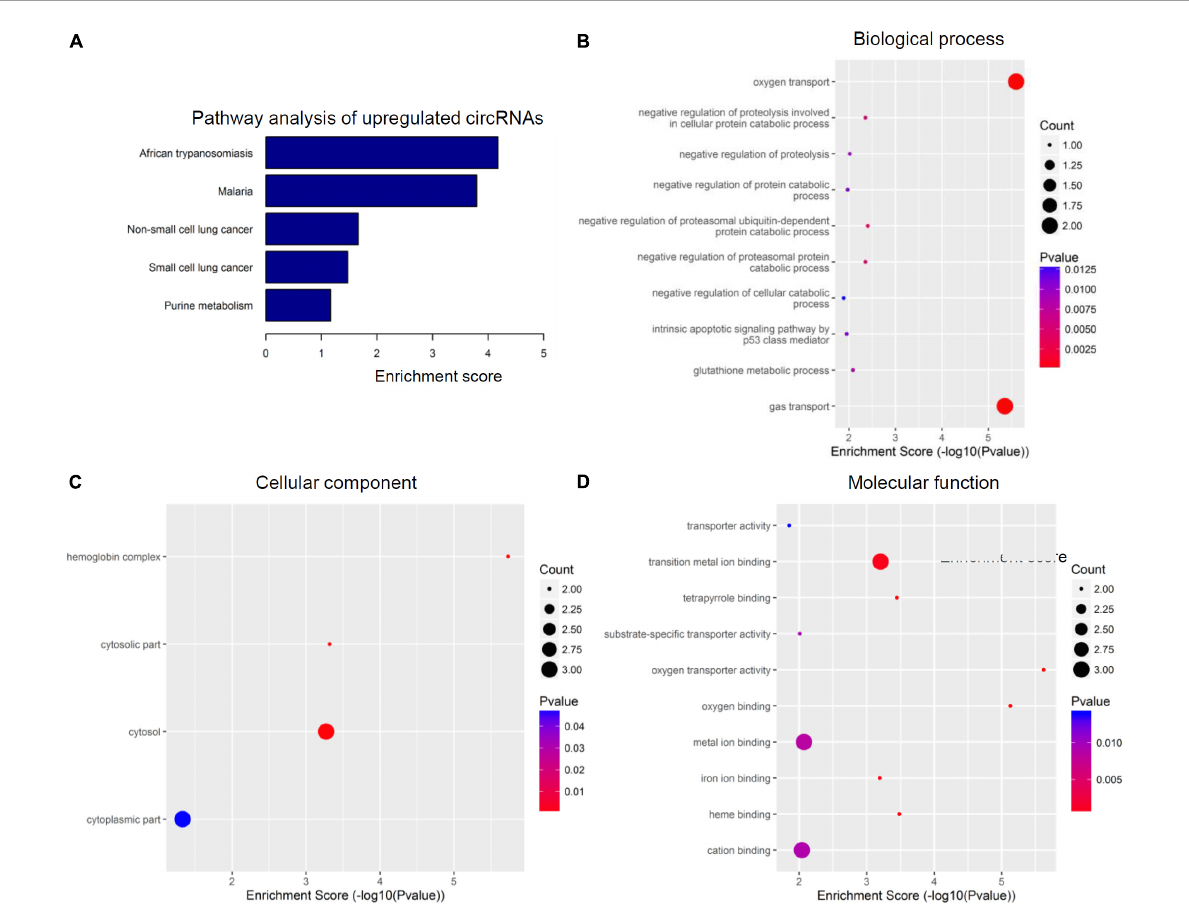
FIGURE3 Kyoto encyclopedia of genes and genomes (KEGG) pathway analysis and gene ontology (GO) function analysis of upregulated circular RNAs (circRNAs) from circulating exosomes. (A) KEGG pathway analysis of upregulated circRNAs from circulating exosomes. (B–D) GO function analysis of upregulated circRNAs from circulating exosomes. (B) Biological process analysis of upregulated circRNAs from circulating exosomes. (C) Cellular component analysis of upregulated circRNAs from circulating exosomes. (D) Molecular function analysis of upregulated circRNAs from circulating